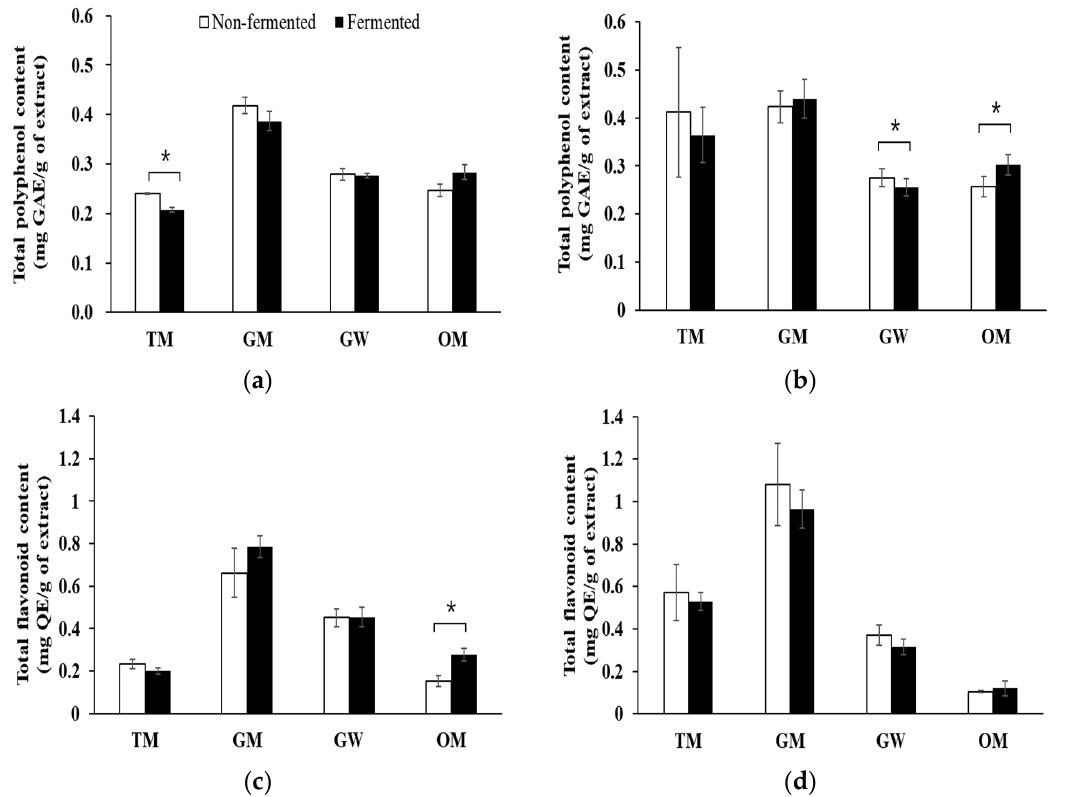
Figure 2. TPC and TFC of HWE and EE after fermentation for 5% ( w/v ) turmeric, ganghwa mugwort, glasswort, and omija. * p < 0.05; ( a ) TPC ‐ HWE; ( b ) TPC ‐ EE; ( c ) TFC ‐ HWE; ( d ) TFC ‐ EE; TM: turmeric; glasswort, and omija. * p < 0.05; ( a ) TPC-HWE; ( b ) TPC-EE; ( c ) TFC-HWE; ( d ) TFC-EE; TM: turmeric; GM: ganghwa mugwort; GW: glasswort; OM, omija. GM: ganghwa mugwort; GW: glasswort; OM,